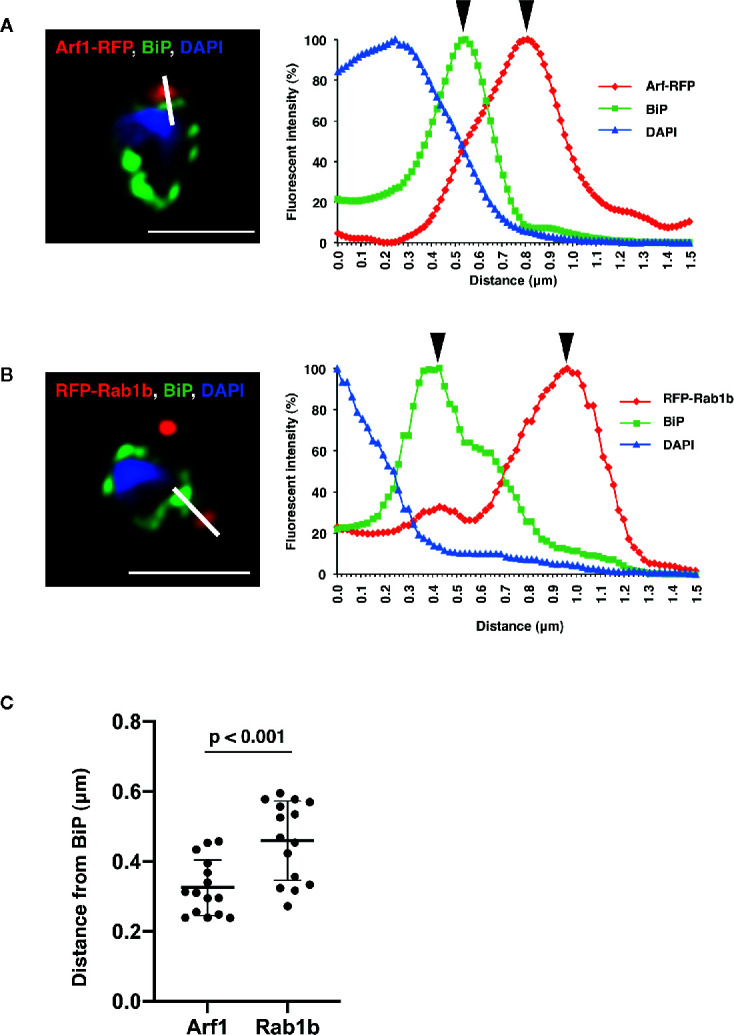
Super-resolution imaging showing the fine differences between PfBiP and PfArf1 or PfRab1b. Synchronized parasites, expressing PfArf1-RFP (A, red) or RFP-PfRab1 (B, red), were sampled at early trophozoite stage and fixed and subjected indirect immunofluorescence analysis with the anti-PfBiP antibody (green) and DAPI (blue). Fluorescence intensities along the bold white lines are indicated in the graphs on the right. The fluorescence intensity was calculated as the percentage of the highest signal intensities. Black arrowheads depict the peaks of RFP and PfBiP intensities. The bars indicate 2 µm. (C) The smallest calculated distances between (A, B) in 15 independent parasites were plotted, and the average (bold bars) and standard deviation (thin bars) are indicated. A test for statistical significance was evaluated using the Student’s t-test.